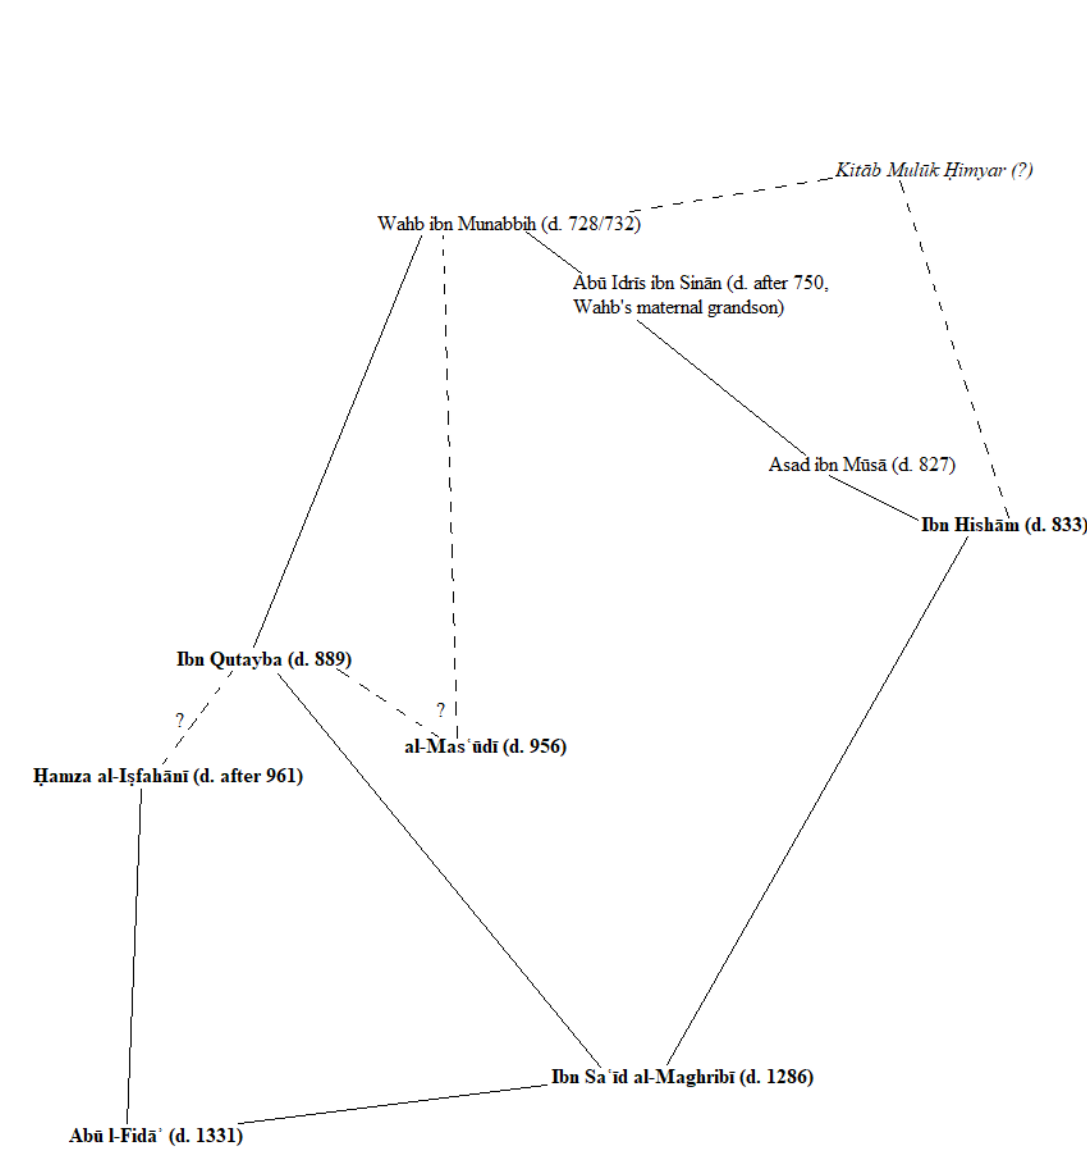
Figure 1 The Kings of Ḥimyar